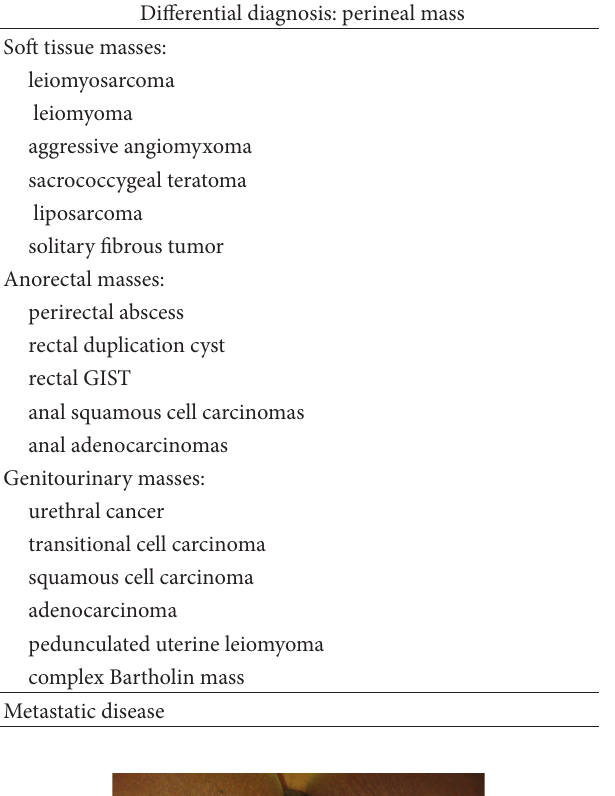
Table 1: Differential diagnosis for perineal masses [1, 3, 5, 7].